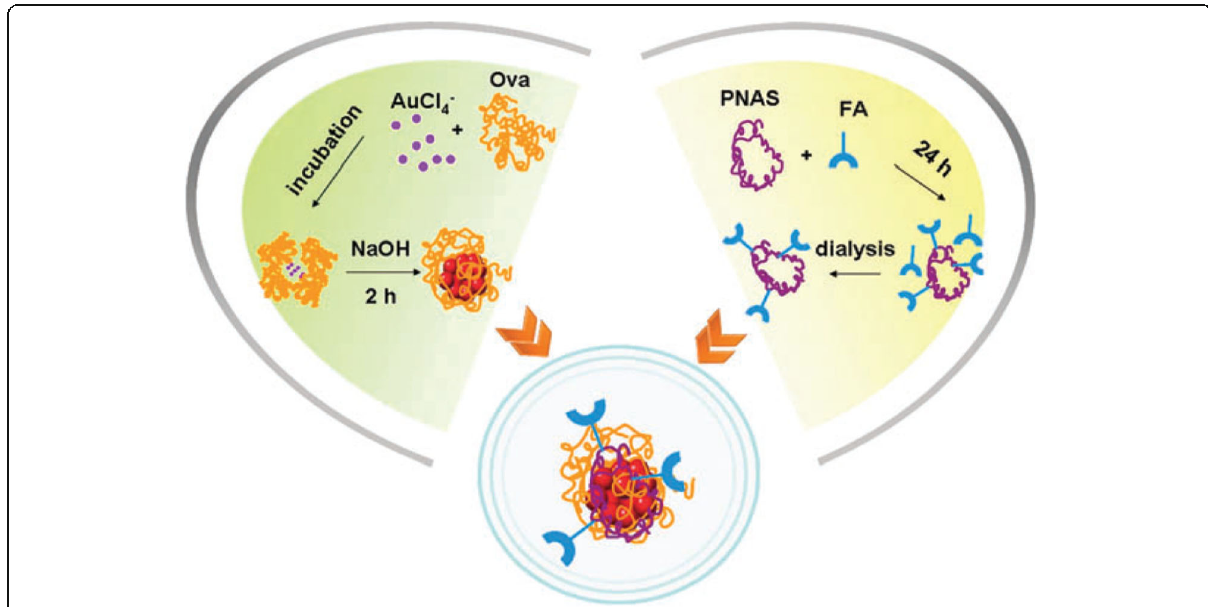
Fig. 7 Schematic of the formation of FA-Ova-AuNCs for cancer cell imaging